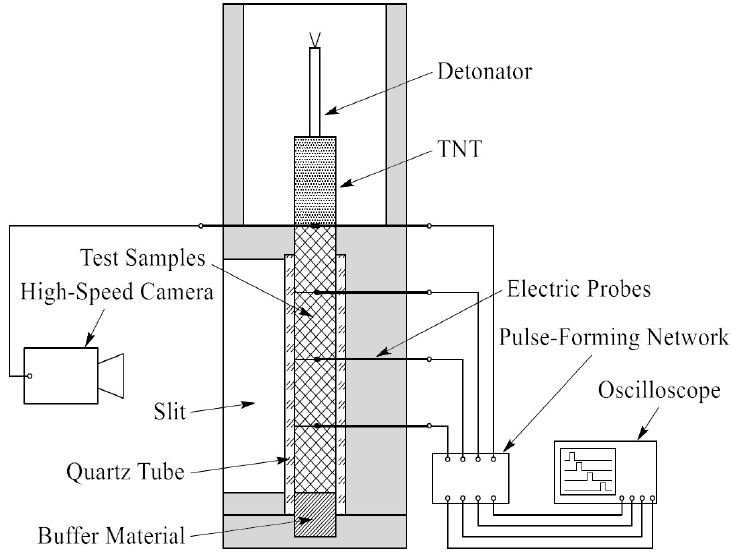
Figure 5. Schematic diagram of the experimental setup. TNT: trinitrotoluene.